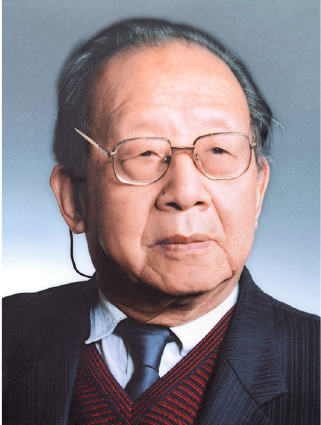
Figure 1. Professor Zhengyi Wu (June 1916 – June 2013).